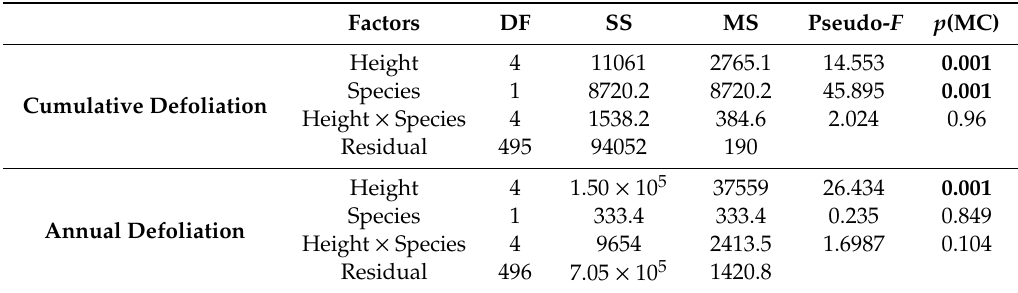
Figure 5. Cumulative defoliation level (%) among height classes (cm) for both seedling species combined ( A ) and between the conifer species (balsam fir and black spruce) ( B ). Annual defoliation level (%) among the height classes (cm) for all seedlings ( C ) and among species (balsam fir and black spruce) ( D ). Vertical bars show the standard error. Different letters represent significant differences between classes ( p < 0.05), following A > B > C. Table 2. Results of permutational multivariate analysis of variance (PERMANOVA) for cumulative and annual defoliation between height, species, and height × species, including degrees of freedom (DF), sum of squares (SS), mean squares (MS), and Monte Carlo permutation test p -values ( p (MC)). Values in bold are